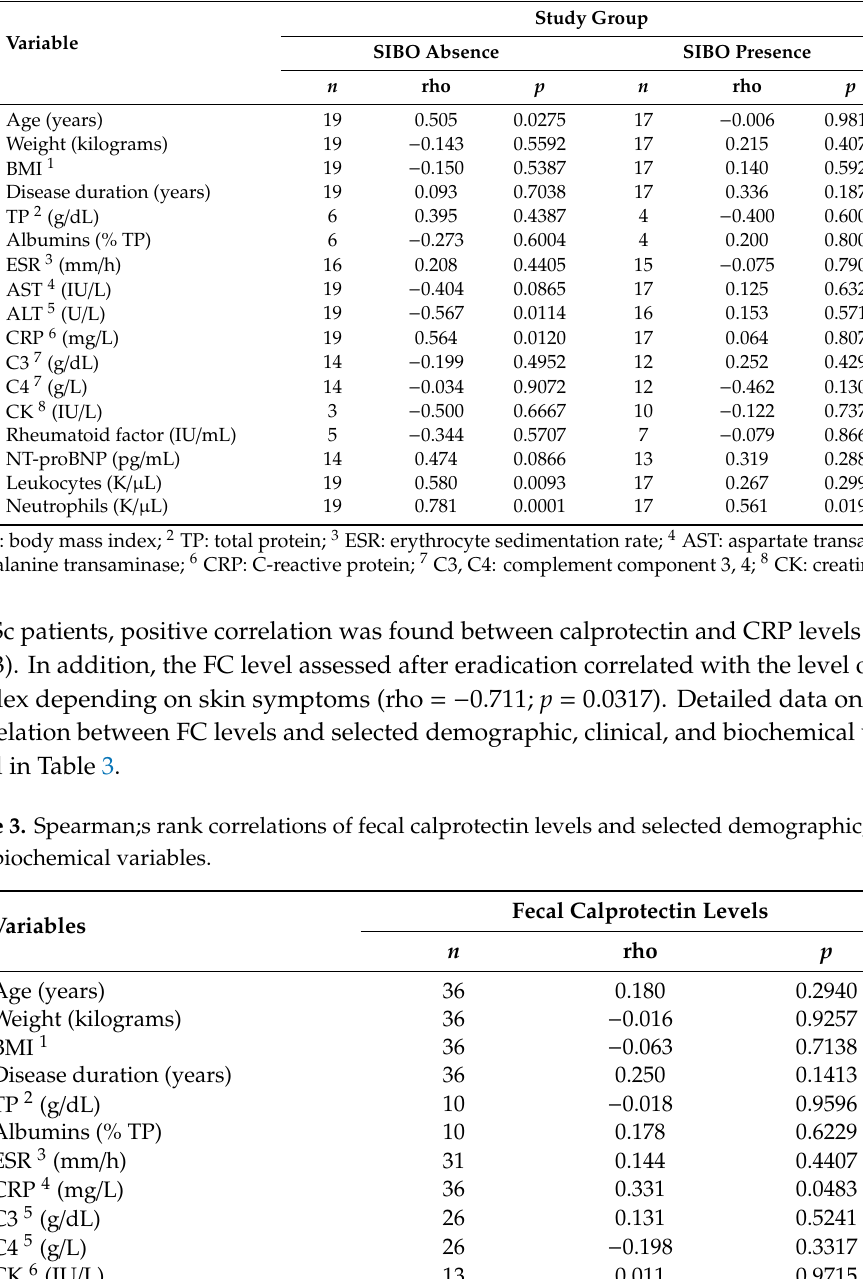
Table 2. Spearman’s rank correlations between fecal calprotectin levels and selected demographic, clinical, and laboratory variables depending on SIBO presence.